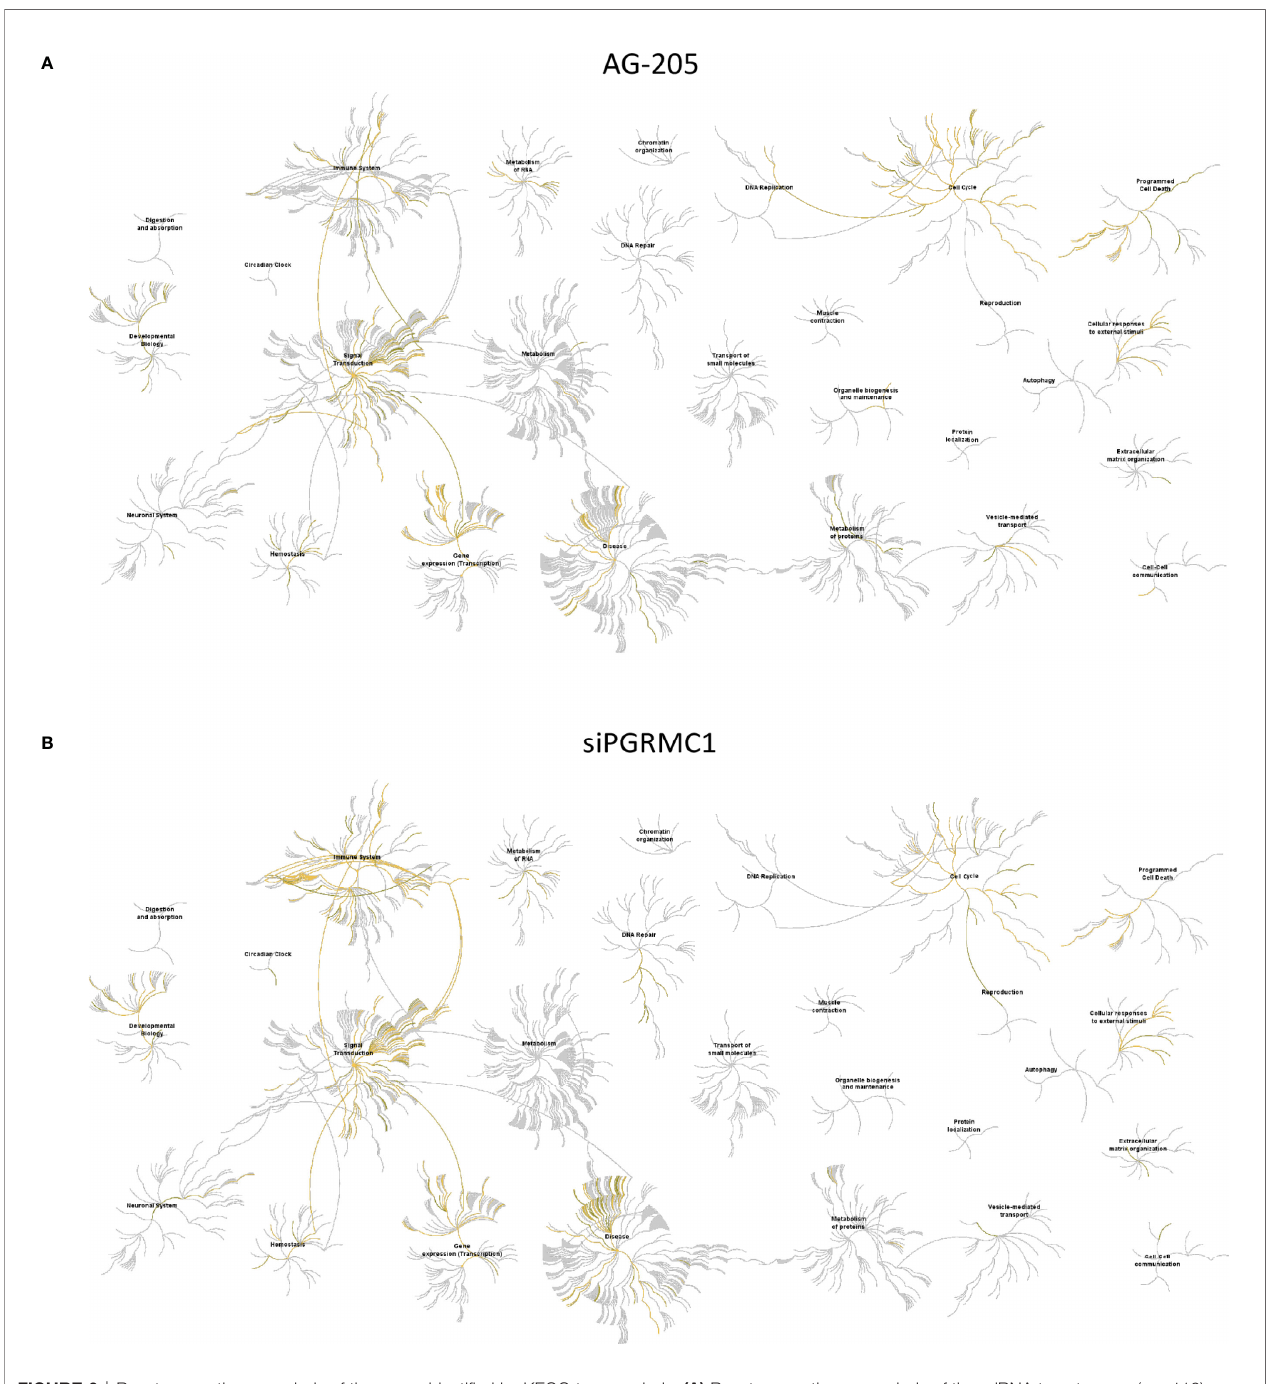
FIGURE 6 | Reactome pathway analysis of the genes identi fi ed by KEGG term analysis. (A) Reactome pathways analysis of the miRNA target genes (n = 112) identi fi ed following AG-205 treatment illustrates increased pathway involvement. (B) Top pathways involved within the miRNA target genes (n = 84) observed following PGRMC1 silencing were also mapped. Over-represented pathways are highlighted in yellow. All overexpressed pathways are from gene lists of formerly annotated and published